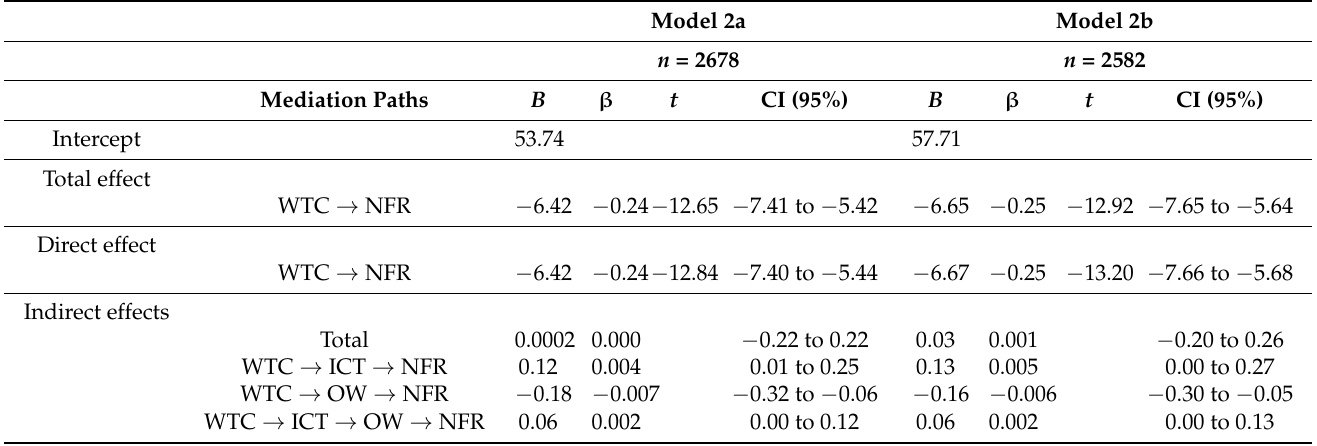
Table 4. Total, direct and indirect effects estimated for the serial mediation model relating work time control (WTC), work-related ICT use, and overtime work (OW) to need for recovery (NFR), first without (Model 2a) and then with adjustment (Model 2b) for age, gender and children at home. Unstandardized and standardized coefficients are reported. Model 2a Model 2b n = 2678 n =